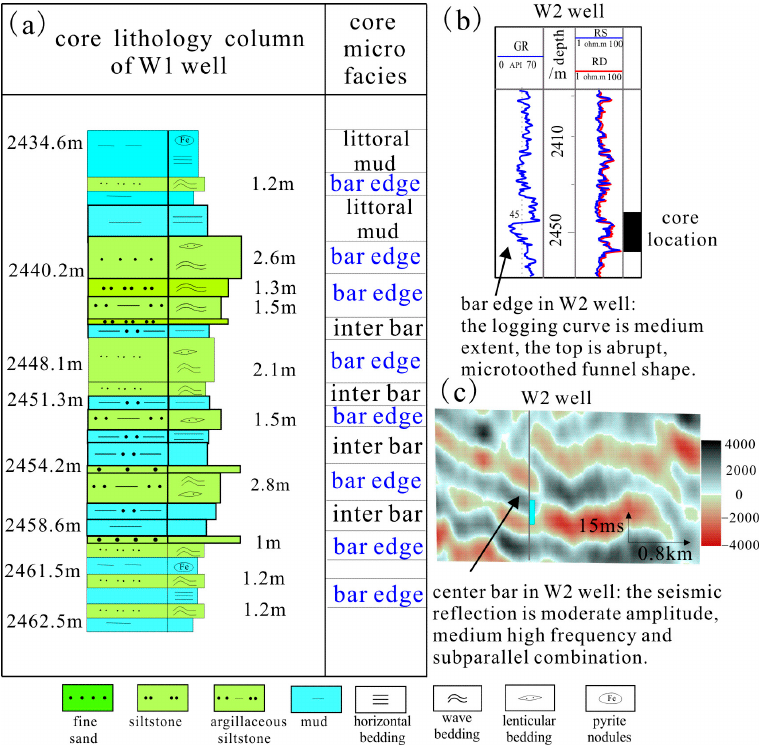
Figure 9. The core lithology column ( a ), logging motifs ( b ), and seismic reflection of the B member sandbar edge microfacies ( c ).